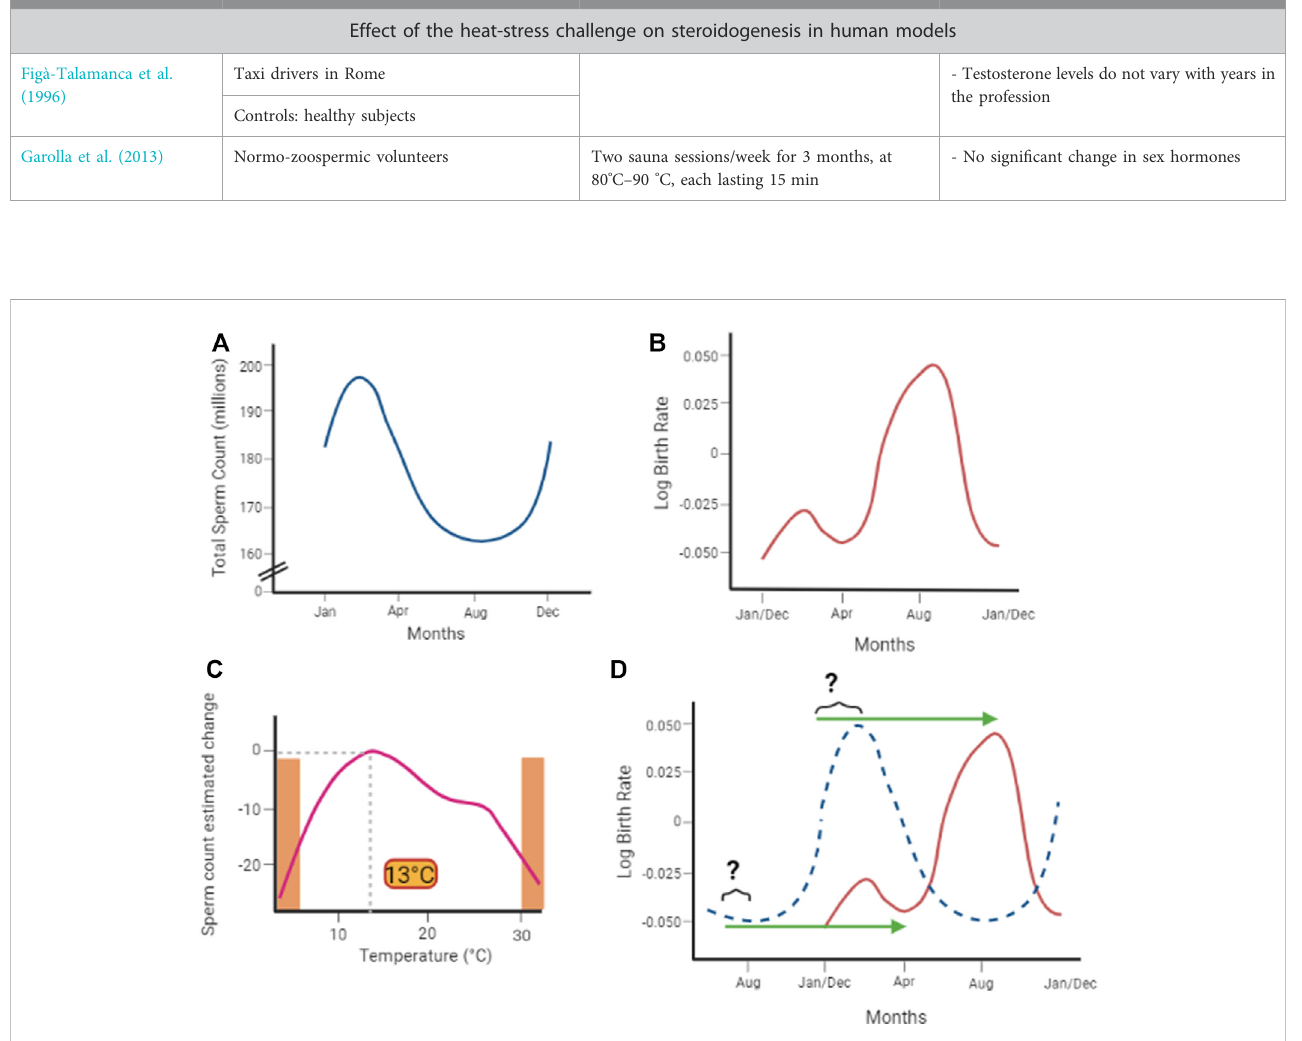
FIGURE 3 (A) Available epidemiological studies describe a seasonal trend of semen sperm count and sperm parameters, highly correlated with the environmental temperature. (B) Ambient temperature of 13 ° C associates with the best spermatogenetic performance, which linearly decreases moving away from this optimum and sharply drops atextreme temperatures (orangeareasintheplot.AdaptedfromZhou etal.,2020). (C) Also, thebirthrate shows aseasonal trend (adapted from Barreca et al., 2018). However (D) , even considering a 9-month-delay effect associated with gestation (green arrows), there is poor consistency with seasonal variation sperm count (dotted blue